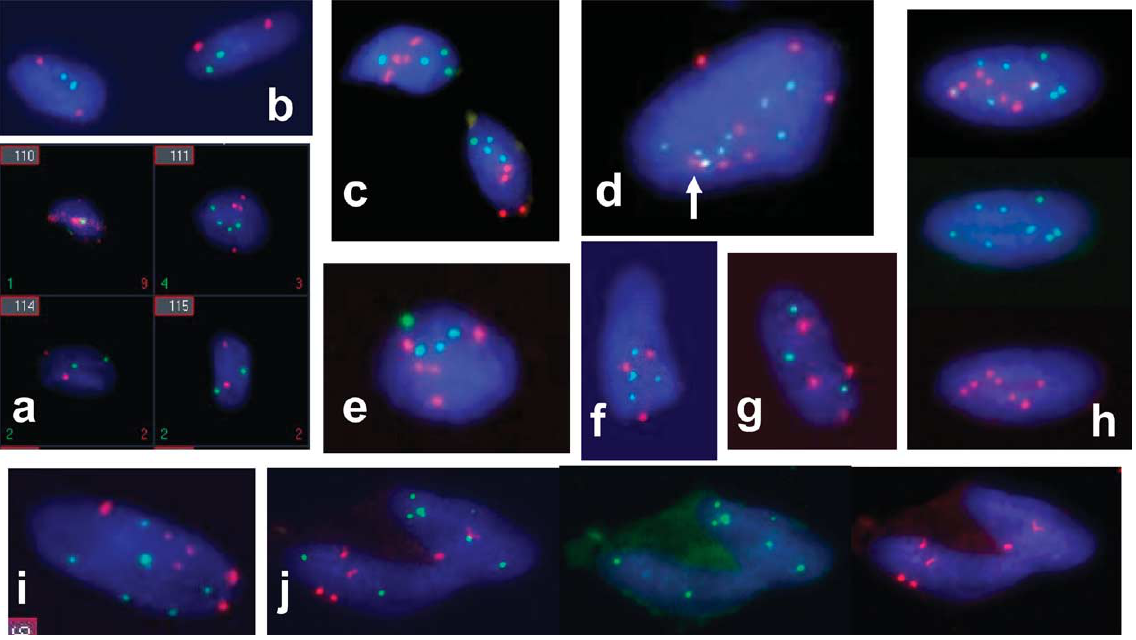
Fig. 5. FISH signals in atypical neurofibroma showing both eusomic-polysomy and aneusomy. (a) Part of slideshow of Metafer 4 containing two disomic and one tetrasomic tumor cells. One cell in the left upper corner proved to be inappropriate for evaluation. (b) Disomic tumor cells. (c) Tetrasomic tumor sells. (d) Octasomic tumor cell. Arrow indicates two red and one green signal. (e) Tetrasomy for chromosome 17 and pentasomy for chromosome 18. (f) Tetrasomy for chromosome 17 and trisomy for chromosome 18. (g) Tetrasomy for chromosome 18 and trisomy for chromosome 17. (h) Octasomy for chromosome 17 and heptasomy for chromosome 18. (i) Hexasomic tumor cell. (j) Splitting tumor cells; note the uneven distribution of chromosomes and the clear aneusomy. (Dual color FISH technique; red signals correspond to chromosome 18, green signals correspond to chromosome